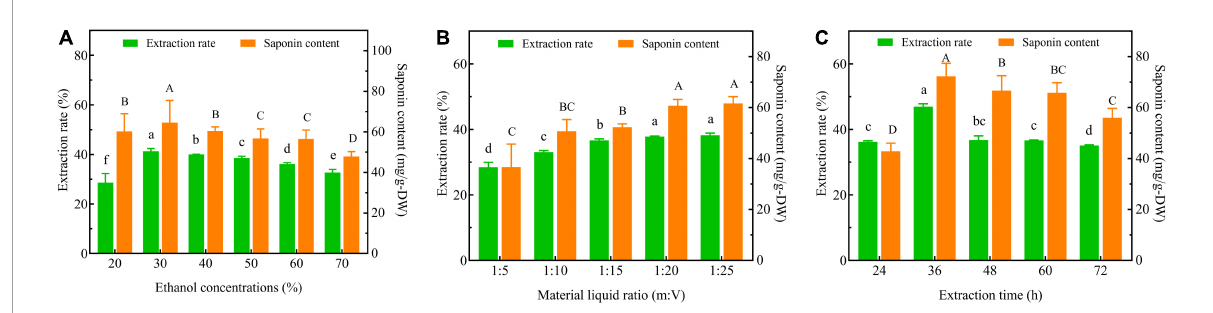
FIGURE1 Extraction rate and total saponin content of SLPN-instant beverage optimized by single factor test. Extraction rate (%) as a function of (A) ethanol concentration (%), (B) material liquid ratio (m:V) and (C) extraction time (h) (Different letters indicate significant differences based on ANOVA post-hoc test at P < 0.05).